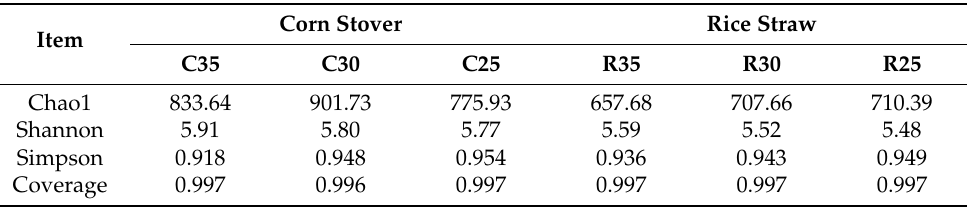
Table 5. Alpha diversity of the bacterial community of corn stover or rice straw silage mixed with soybean curd residue.